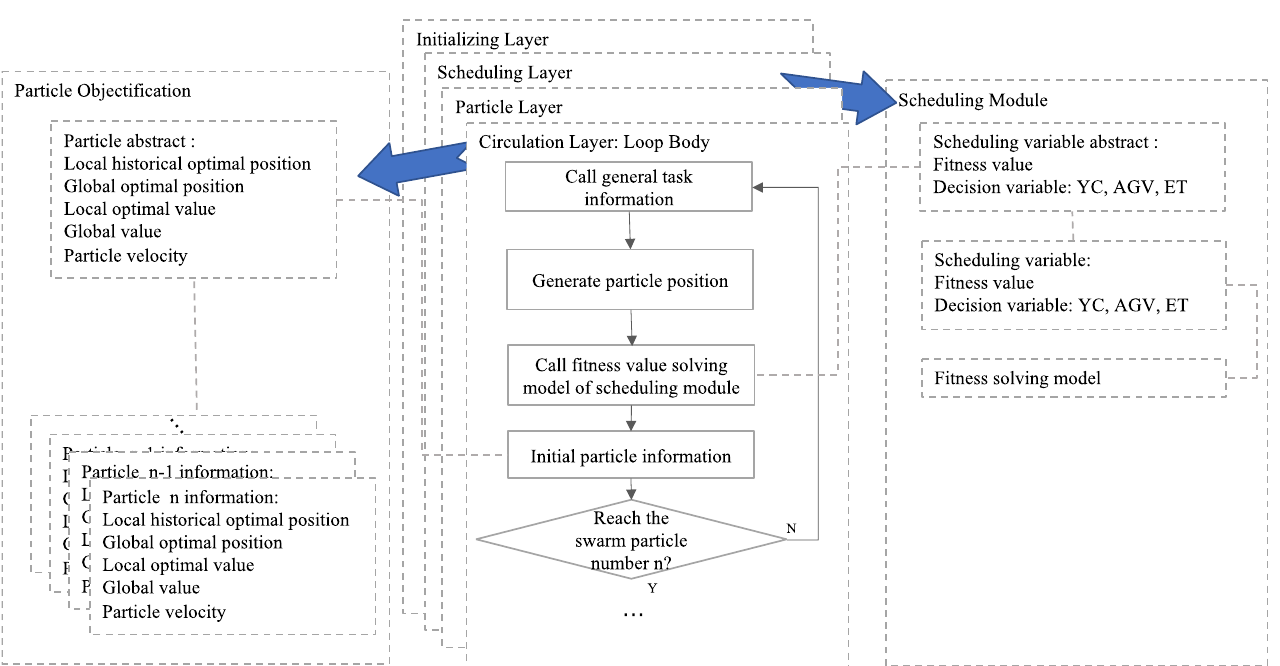
Figure 9. Module layer process.